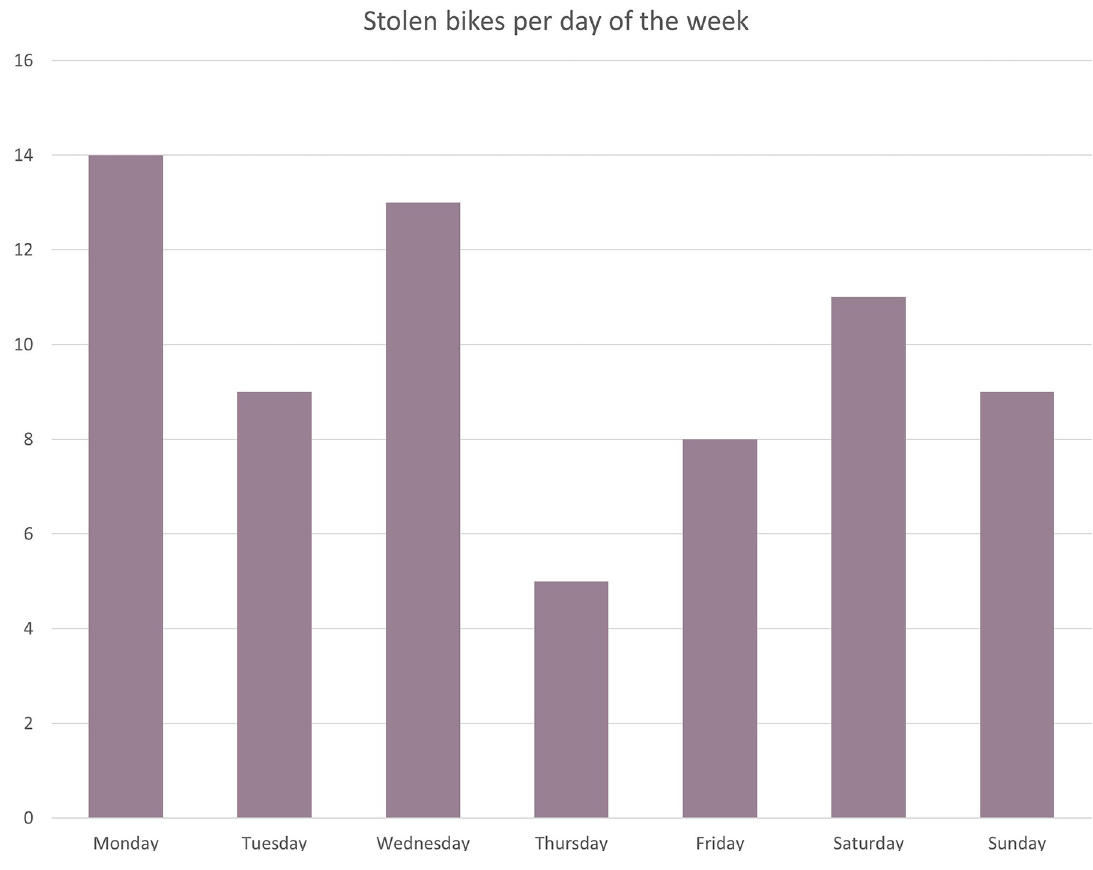
Fig 10. Count of the number of bikes stolen per